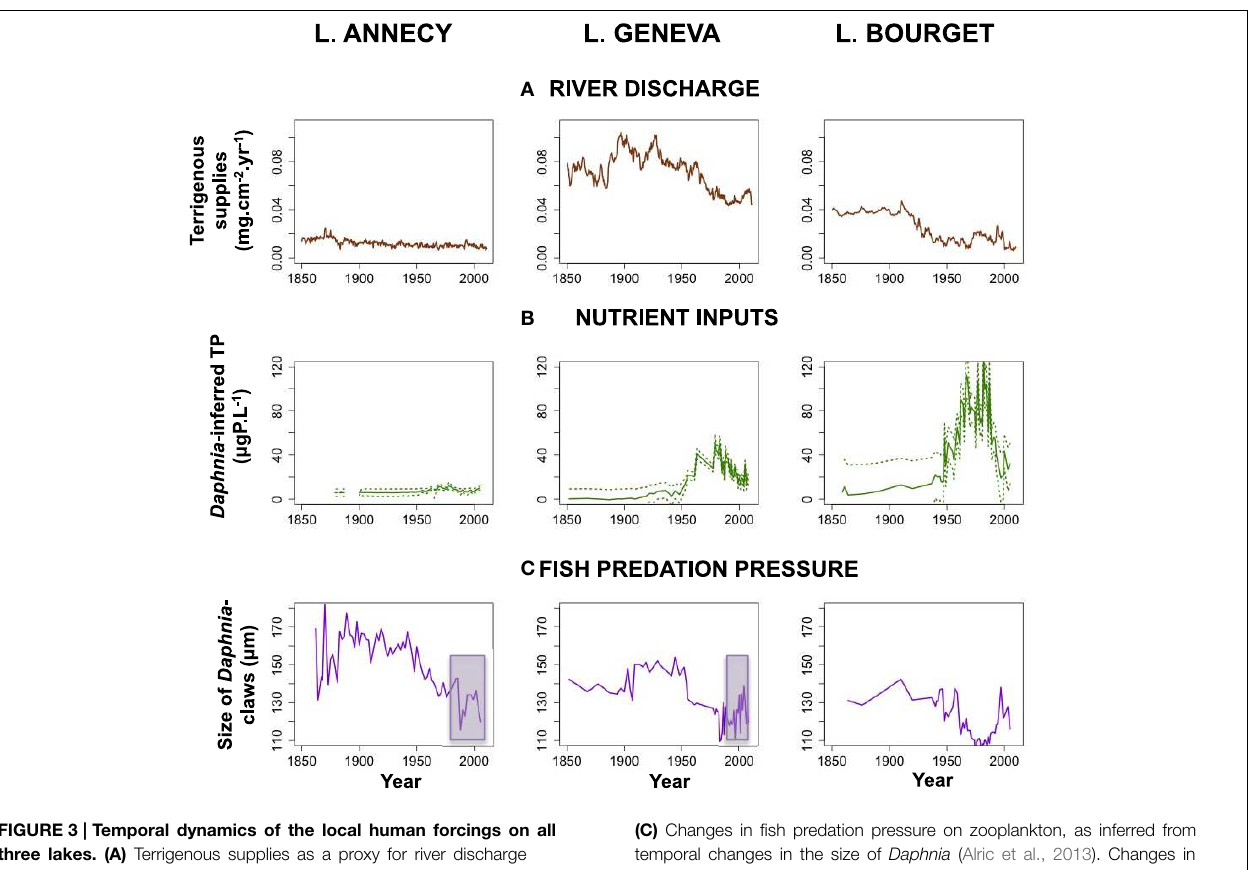
(C) Changes in fish predation pressure on zooplankton, as inferred from temporal changes in the size of Daphnia ( Alric et al., 2013). Changes in fish predation pressure that are decoupled from TP (purple rectangles) are considered as resulting from specific fisheries management practices in Lakes Annecy and